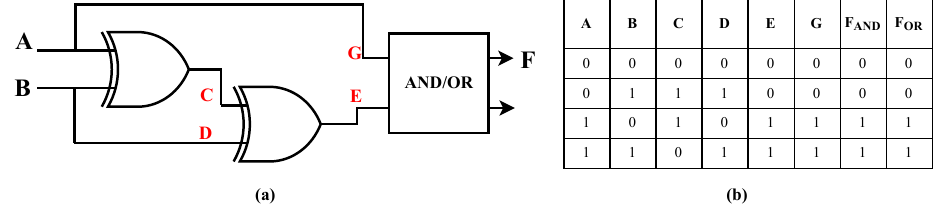
Figure 5. IC fingerprinting using spintronics PGs. ( a ) An example circuit with an SDC-condition- based fingerprinting. ( b ) Truth table of the internal signals and output for AND and OR